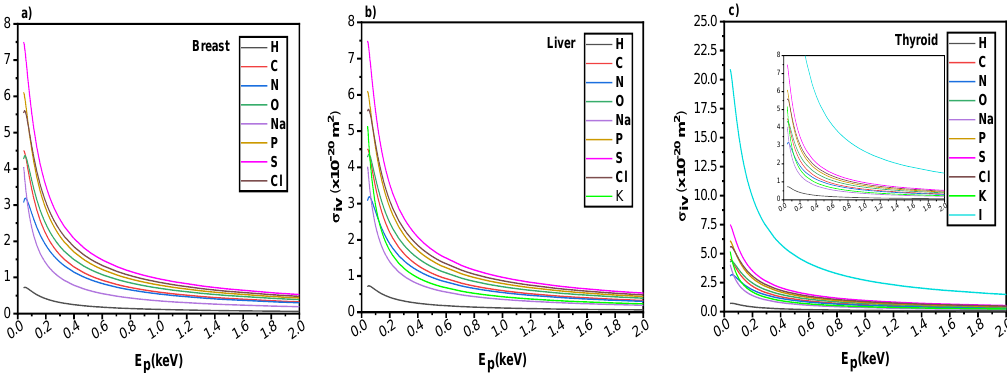
Figure 3: Inelastic valence cross-section as a function of positron energy for (a) breast, (b) liver, and (c)